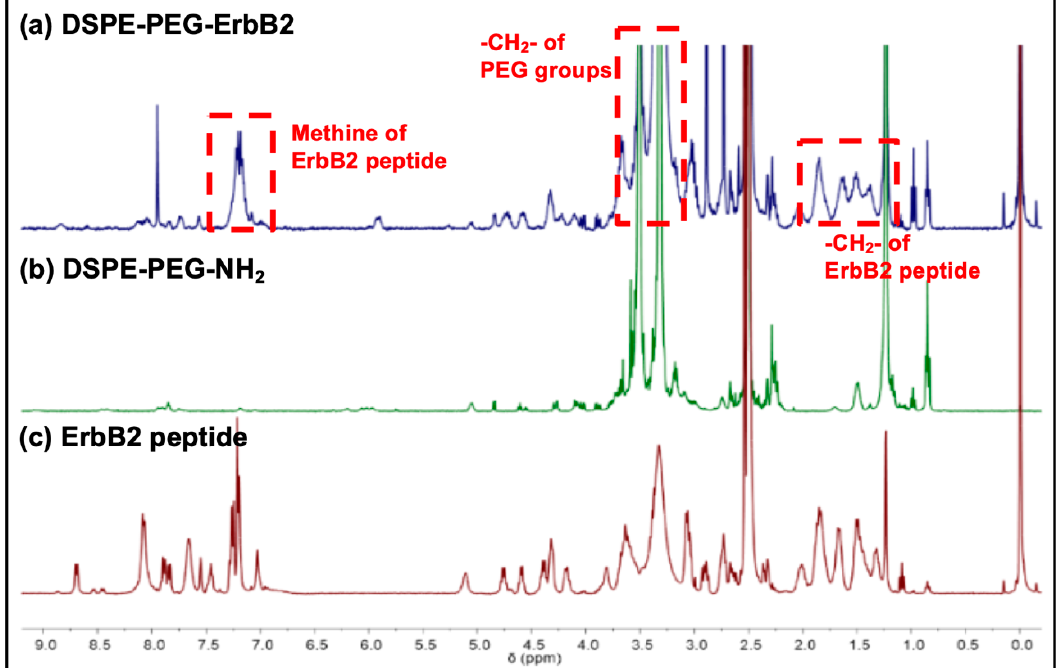
Figure 2. The 1 H NMR spectra of ( a ) DSPE-PEG-ErbB2, ( b ) DSPE-PEG-NH 2 , and ( c ) the ErbB2 peptide. The red dashed squares indicate the chemical shifts of the methine and methylene protons of the ErbB2 peptide and the methylene protons of DSPE-PEG-NH 2 .